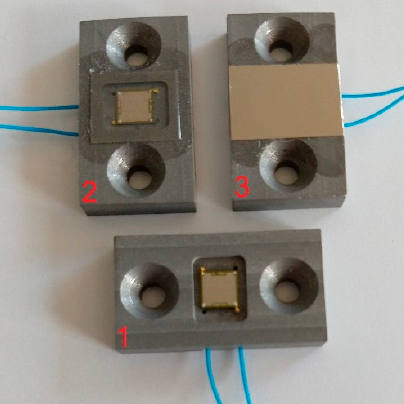
Figure 7. Setups validated in transmission experiments: (1) uncoated CMUT, (2) CMUT with silicone (t = 170 µm) and PEEK (t = 25 µm), (3) CMUT with silicone (t = 170 µm) and titanium (t = 32 µm).